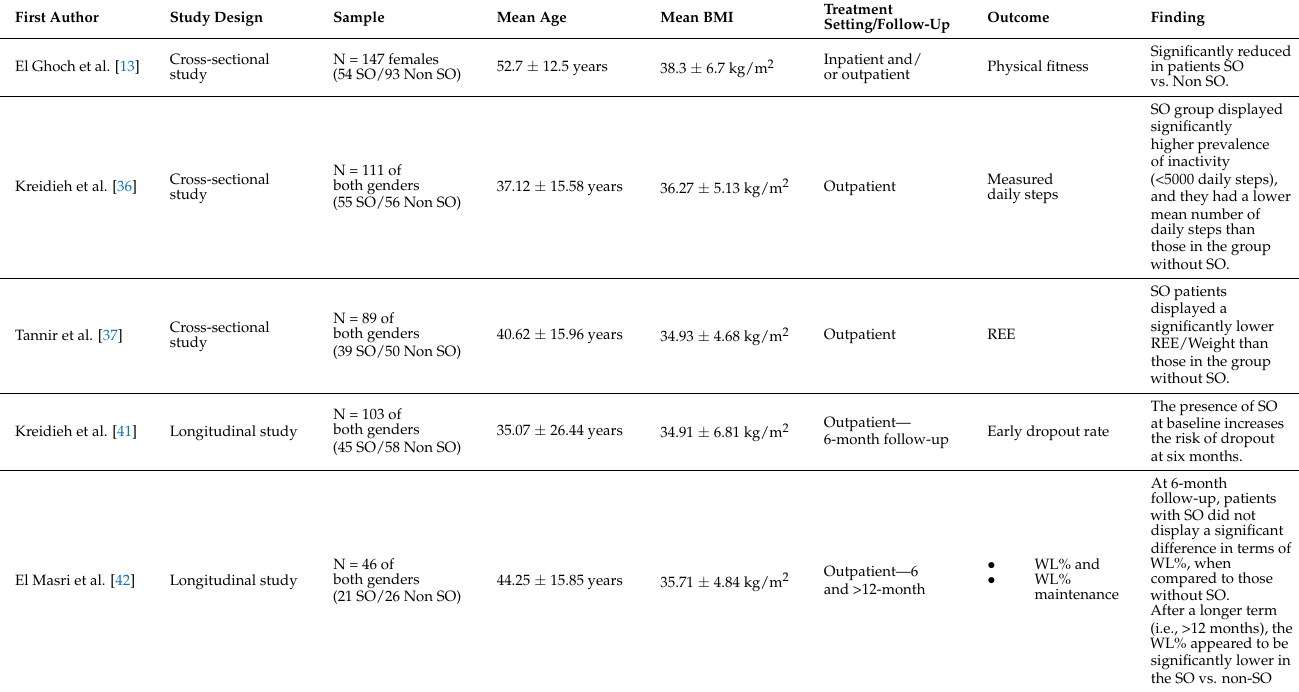
Table 2. SO and weight management outcomes in clinical settings included in the